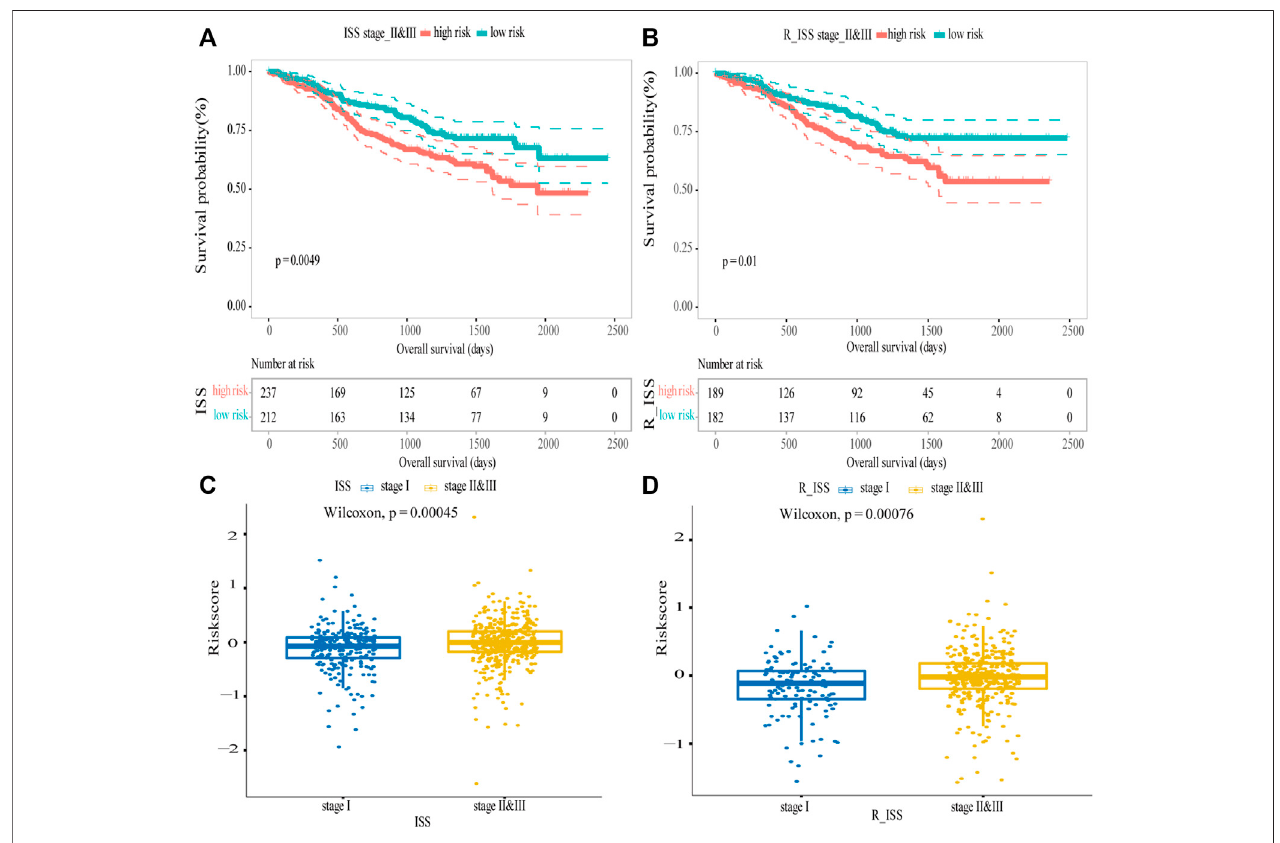
FIGURE 7 | Validation of the fi ve-gene risk score model in ISS and R_ISS. (A) Kaplan – Meier curves of MM patients in stage II and III of ISS ( p (cid:1) 0.0049). (B) Kaplan – Meier curves of MM patients in stage II and III of R-ISS ( p (cid:1) 0.01). (C) Survival differences between stage I and stage II and III of ISS ( p (cid:1) 0.00045). (D) Survival differences between stage I and stage II and III of R_ISS ( p (cid:1) 0.00076). MM patients were divided into high-risk and low-risk groups by the median risk